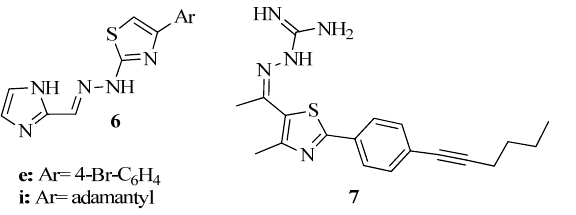
Figure 4. Structures of imidazolothiazole ( 6 ) and 2,5-disubstituted thiazole derivatives ( 7